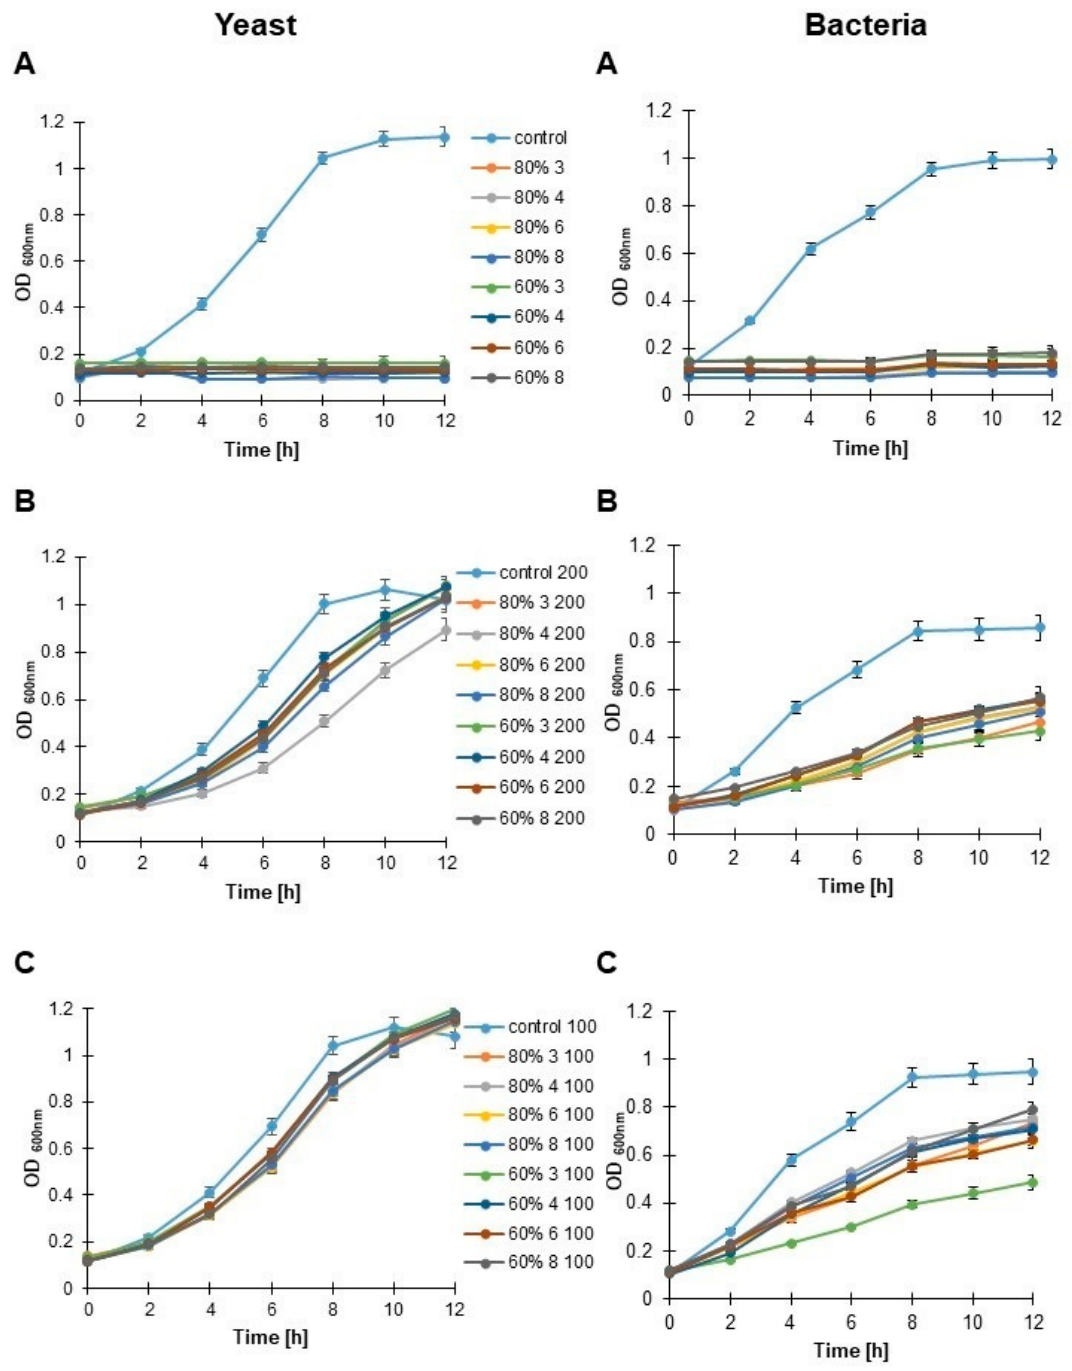
Figure 7. The effect of increasing doses of selected goldenrod honey samples (3, 4, 6 and 8) on bac- budding yeast ( left ) and bacterial ( right ) growth. ( A )—undiluted honey samples, ( B )—samples in terial and budding yeast growth. ( A )—undiluted honey samples, ( B )—samples in dilution 1:5 (200 dilution 1:5 (200 mg/mL), ( C )—samples in dilution 1:10 (100 mg/mL), ( C )—samples in dilution 1:10 (100 mg/mL).